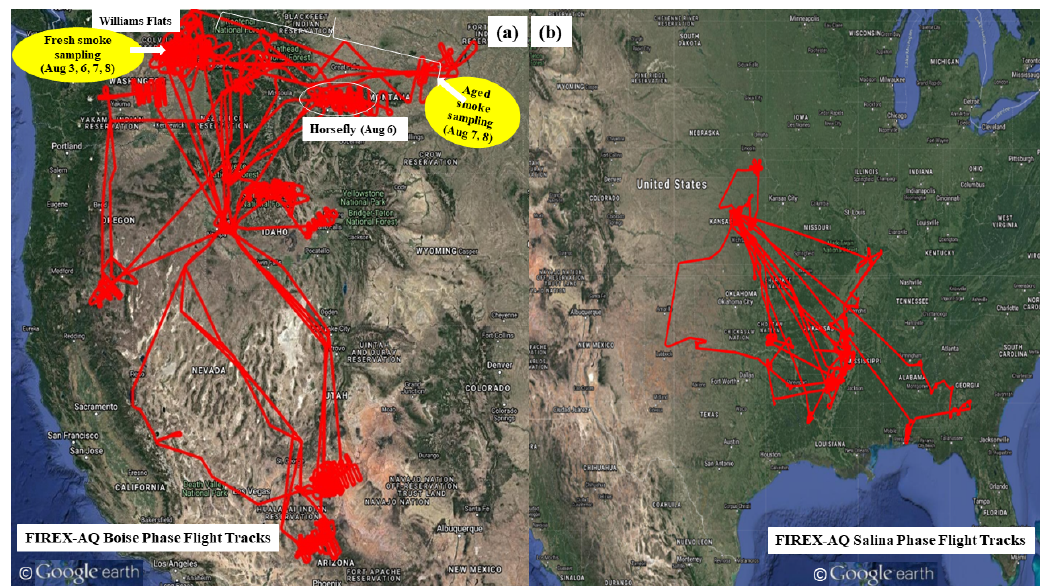
Figure 1. NASA DC-8 flight tracks during the Boise phase ( a , left) and Salina phase ( b , right) of the 2019 FIREX-AQ field campaign. The locations of the Williams Flats fire and Horsefly fire, which are the main focus of this study, are shown (in white) along with the sampling dates and details. Image: © Google